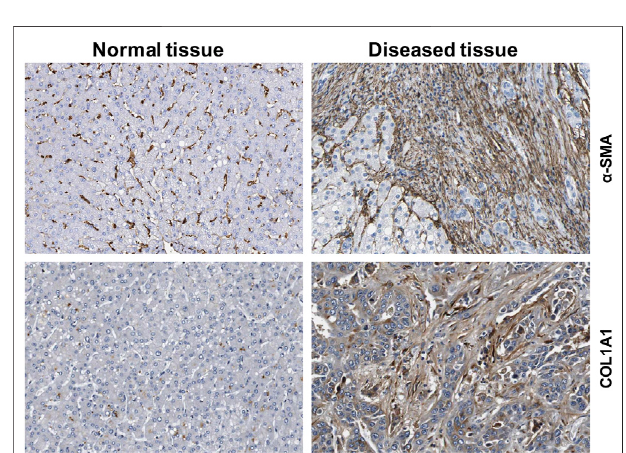
FIGURE 7 | Expression of fi brogenic markers in liver. The fi gure was compiled using immunohistochemical data from the Human Protein Atlas (www.proteinatlas.org/) (Uhlén et al., 2015). α -smooth muscle actin ( α -SMA) and collagen type 1 α 1 (COL1A1) proteins were stained in normal and diseased